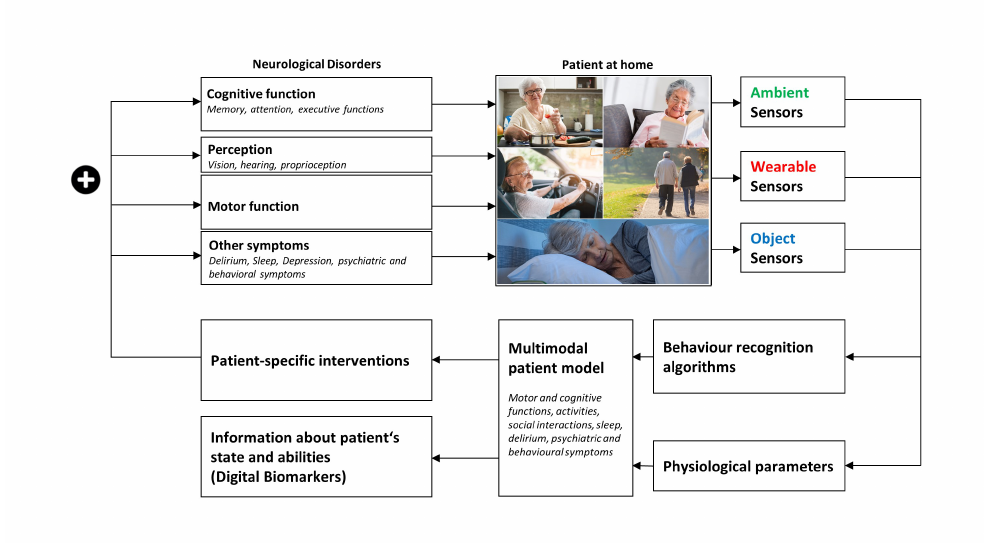
Figure 7. Overview of the general approach pursued at NeuroTec: novel sensor technologies are applied to yield a combination of ambient context information with specific information from body mounted sensors. These data are then used to develop a multimodal patient model that enables individualized